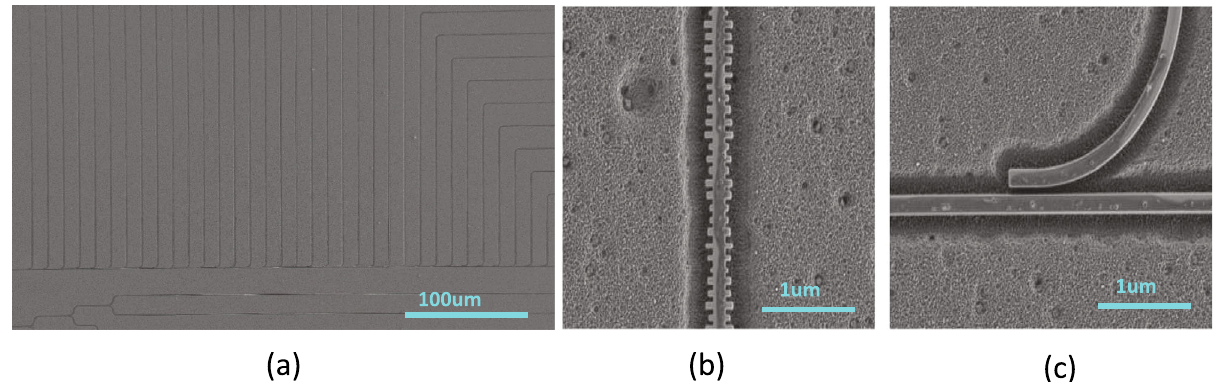
Fig. 3 Images of the fabricated devices. a Shows the SEM image of the overview of the entire spectrometer. b , c Gives the zoom-out view of individual SWF as well as the tap-based